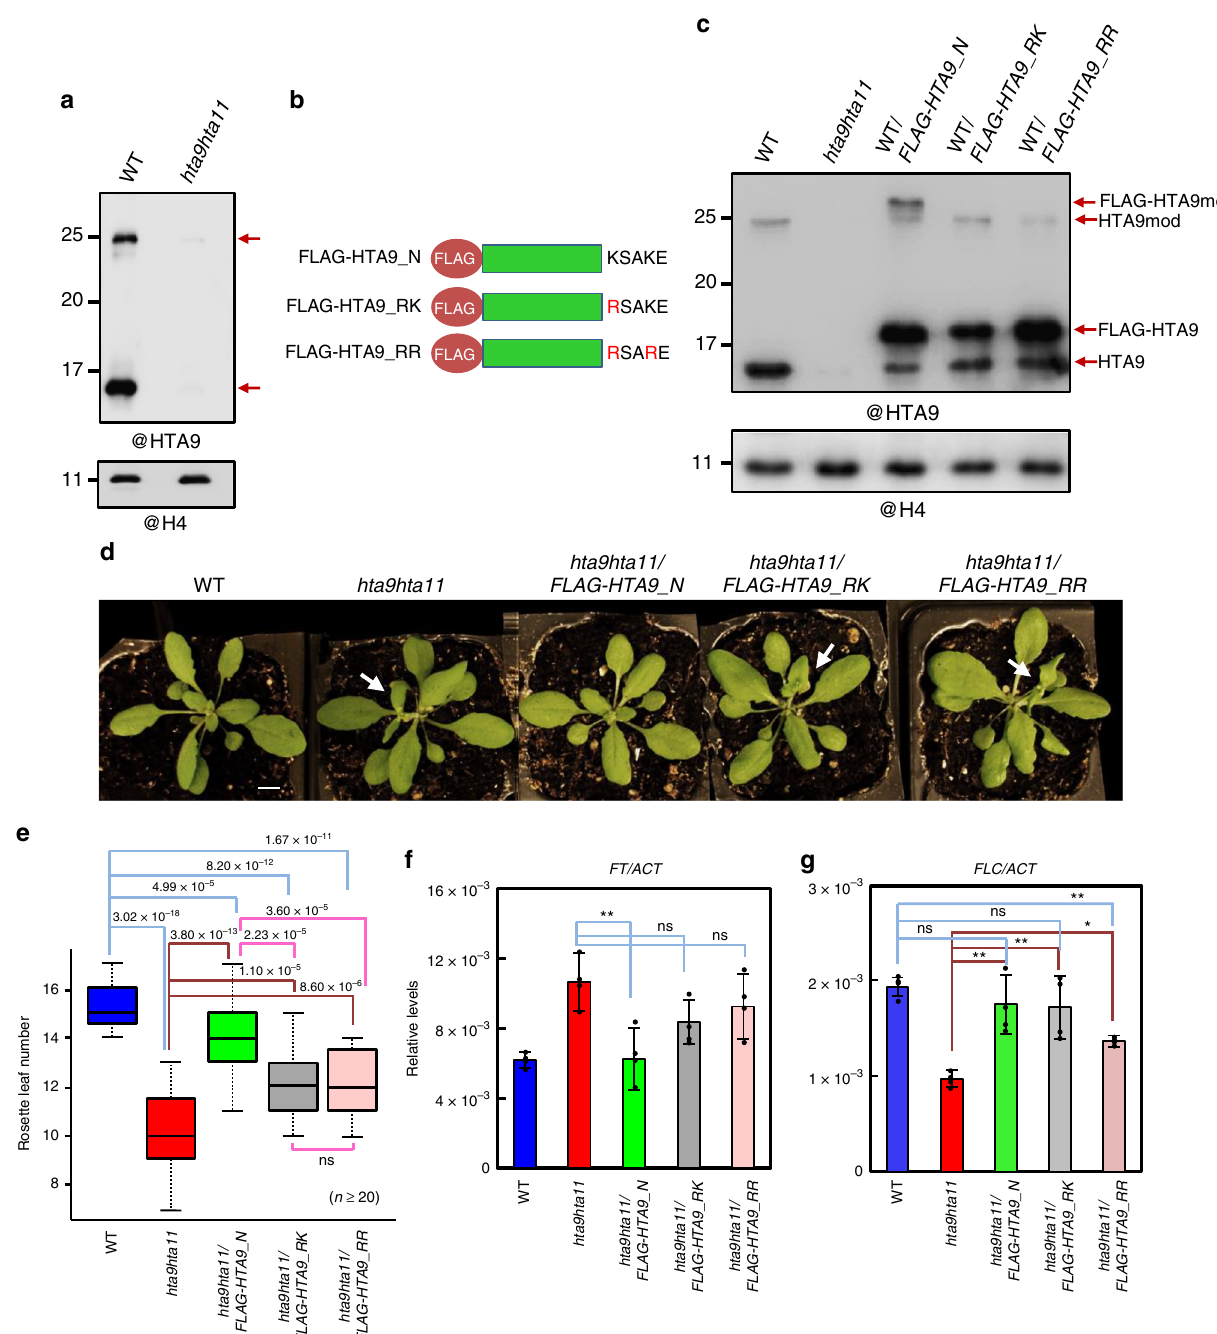
Fig. 1 A modi fi ed form of H2A.Z is required to regulate fl owering time. a Western blot (WB) analysis of HTA9 levels in histone enriched extracts of wild- type (WT) and hta9hta11 mutants at 7 days after germination (DAG; upper panel). The same blot was probed with anti-H4 antibody for loading control (bottom panel). Arrows indicate the bands recognized by the antibody. b Schematic representation of the C-terminal region of FLAG-tagged HTA9 native construct ( FLAG-HTA9_N ) or mutated in which K129 or both K129 and K132 were replaced by R ( FLAG-HTA9_RK and FLAG-HTA9_RR , respectively). c WB analysis of HTA9 and FLAG-HTA9 levels in WT, hta9hta11 , WT / FLAG-HTA9_N , WT / FLAG-HTA9_RK , and WT / FLAG-HTA9_RR (upper panel). Arrows indicate the bands recognized by the antibody. The same blot was probed with anti-H4 antibody for loading control (bottom panel). d Picture showing WT, hta9hta11 , hta9hta11/FLAG-HTA9_N , hta9hta11/FLAG-HTA9_RK , and hta9hta11/FLAG-HTA9_RR plants at 24 DAG growing under long day conditions. Arrows indicate the presence of elongated shoot. Bar indicates 1 cm. e Box plots indicating the number of rosette leaves at bolting in different genotypes. “ n ” indicates the number of plants. In each case, the median (segment inside rectangle), upper and lower quartiles (boxes), and minimum and maximum values (whiskers) are indicated. p Value of signi fi cant differences as determined by Student ’ s t test are indicated. f Relative FT expression levels in the different genotypes at 12 DAG. ACTIN2 ( ACT2 ) was used as an internal control. Error bars indicate standard deviation of n = 4 biological replicates. Data points are indicated in the bar charts. g Relative FLC expression levels in different genotypes at 12 DAG. ACT 2 was used as an internal control. Error bars indicate standard deviation of n = 4 biological replicates. Data points are indicated in the bar charts. Signi fi cant differences as determined by Student ’ s t test are indicated (** P < 0.01; * P < 0.05; ns, not signi fi cant). Source data of Fig. 1a, c, e – g are provided as a Source Data fi